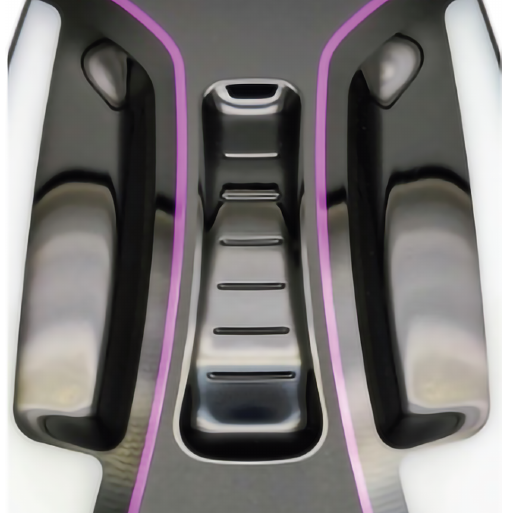
Figure 2. Relief of tactile cues perceptually distinguishable over the control panel